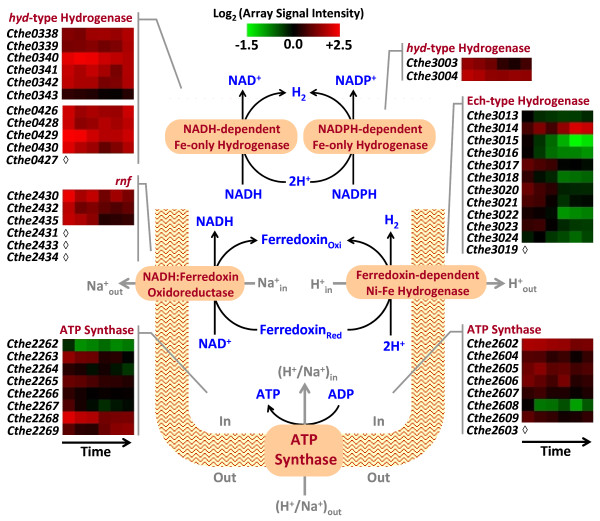
Expression of genes involved in maintaining cellular REDOX status. Heat plot representation of transcript expression [as Log2 (array signal intensity)] for genes (known and putative) involved in cellular reduction and oxidation reactions, co-factor recycling, hydrogen production and ATP synthesis, over the course of Avicel® fermentation by Clostridium thermocellum ATCC 27405; open diamond - Microarray data is not available.